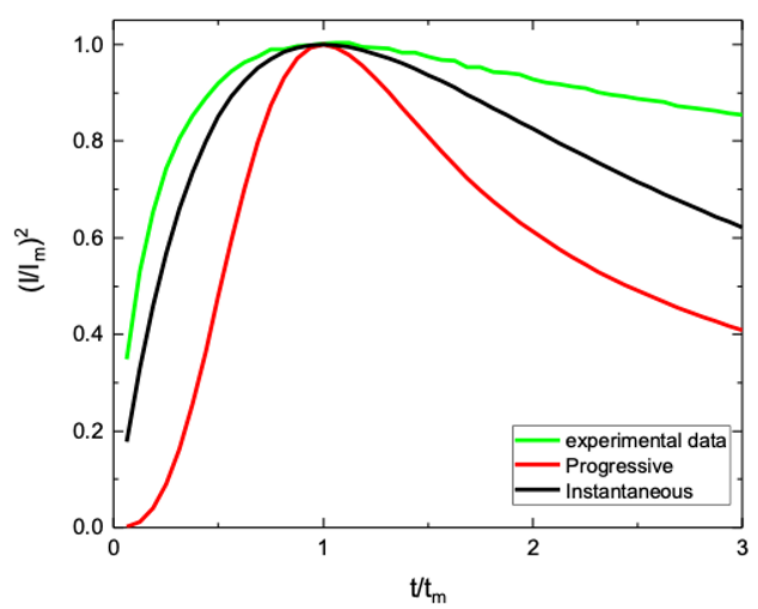
Figure 6. Comparison between the experimental data (green curve) and the theoretical data of the Sharifker–Hills model for instantaneous and progressive nucleation (black and red curve, respectively). The experimental curve is related to electrodeposition of WO 3 by using V d = 0.35 V and t d = 3 min.